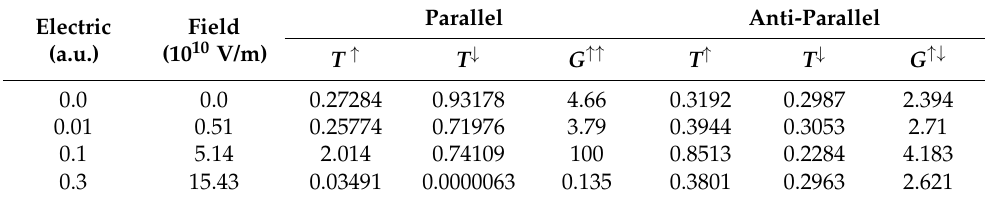
Table 3. Effect of electric field on the spin conductance of the Co(111)/hBN/Co(111) stack.